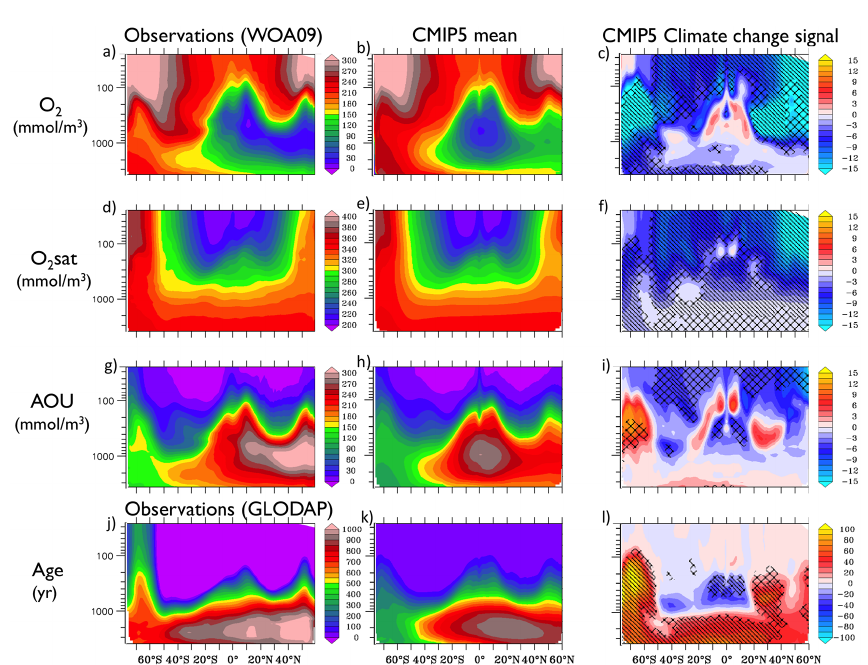
Figure 8. Observational climatologies from WOA09 and GLODAP data sets (left column), CMIP5 multi-model mean historical simulations for the period 1960–1999 (middle column) and CMIP5 multi-model mean future projections for the period 2060–2099 referenced to the historical period (right column) for oxygen concentration (mmolm − 3 ) on the first row, O 2 sat (mmolm − 3 ) on the second, AOU (mmolm − 3 ) on the third, and water-mass age (yr) on the last row, all averaged zonally between 180 ◦ W and 100 ◦ W for a number of depths ( y axis shows depth inm). The predicted 100-year change panels include diagonal pattern for trends that are consistent across CMIP5 models at the 90% level, and crossed patterns for 80% level. The observed age was multiplied by 2 in order to match the CMIP5 magnitude qualitatively. Only four of the studied models reported age. The metrics for 100-year change agreement is explained in the Methods section.